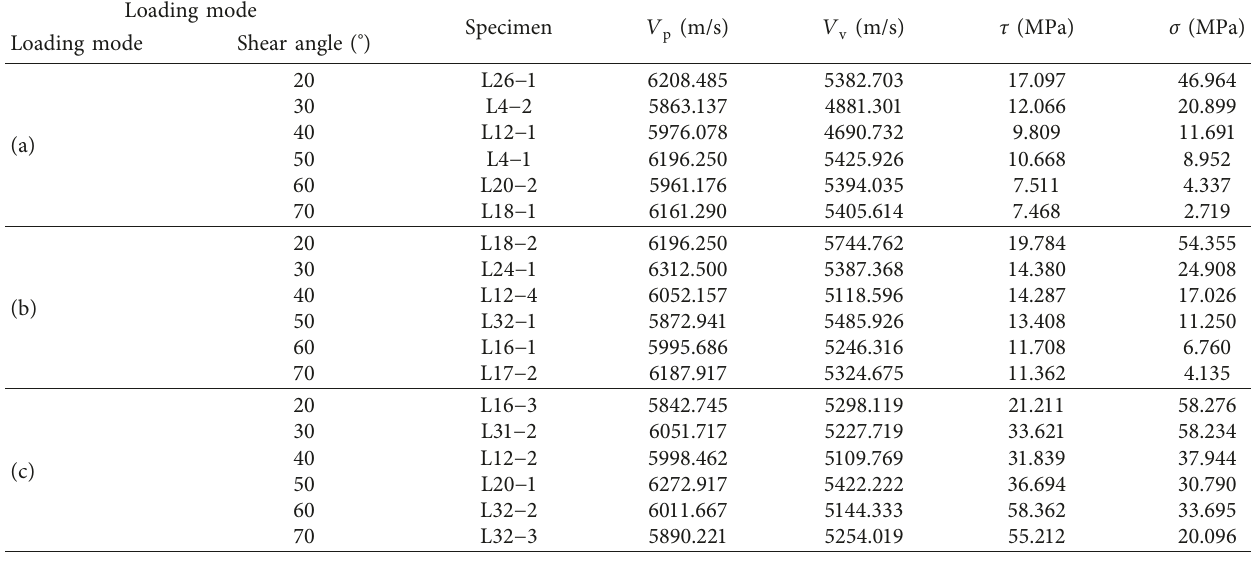
Table 1: Results of shear tests for